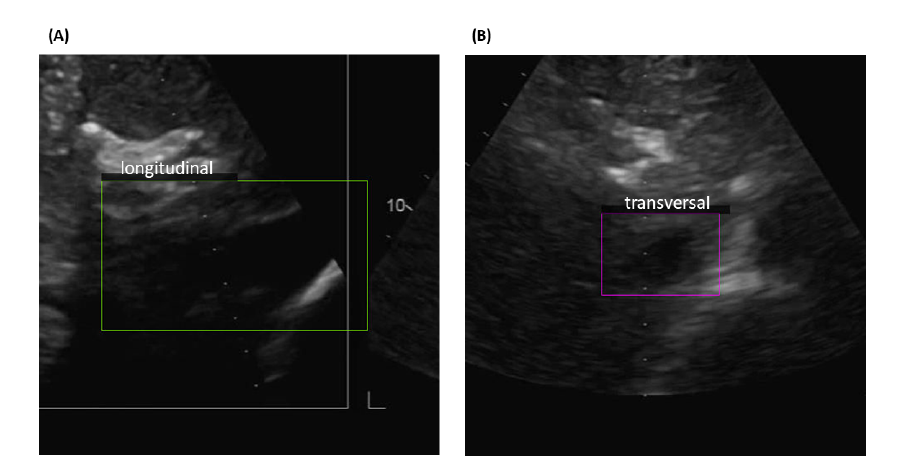
Figure 3. Examples of YOLO detection outputs in difficult cases, in which the IVC is not clearly visible. ( A ) Longitudinal and ( B ) Transversal view.